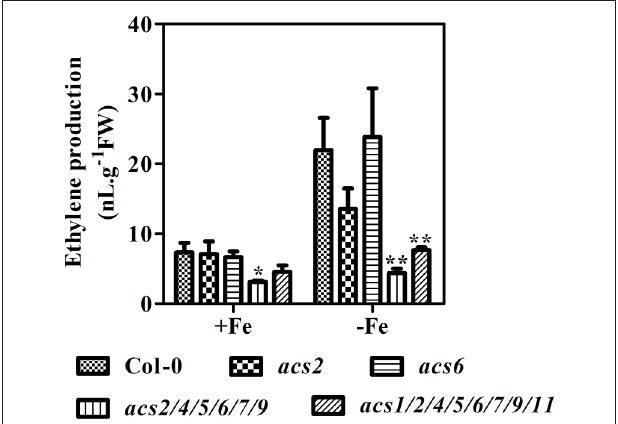
FIGURE 4 | Transcription levels of Fe-deficiency responsive genes in acs2 and acs6 mutant plants. Ten day old seedlings cultured in swimming medium were transferred to Fe-deficient medium for 7 days and sampled for RNA extraction. All values are expressed relative to the expression level under Fe-sufficient conditions (control—set to 1.0) as appropriate. Data are shown as the mean ± SEM ( n = 3 ). Column marked with “ * ” indicate a significant difference ( P < 0.05 ).